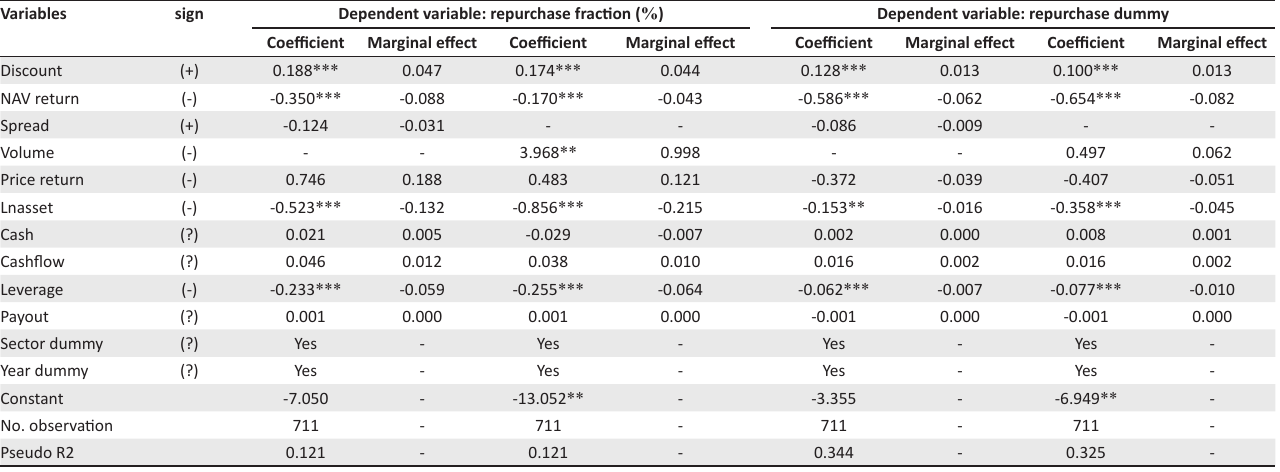
TABLE 6: Multivariate analysis for the decision of fund-year repurchase transactions.